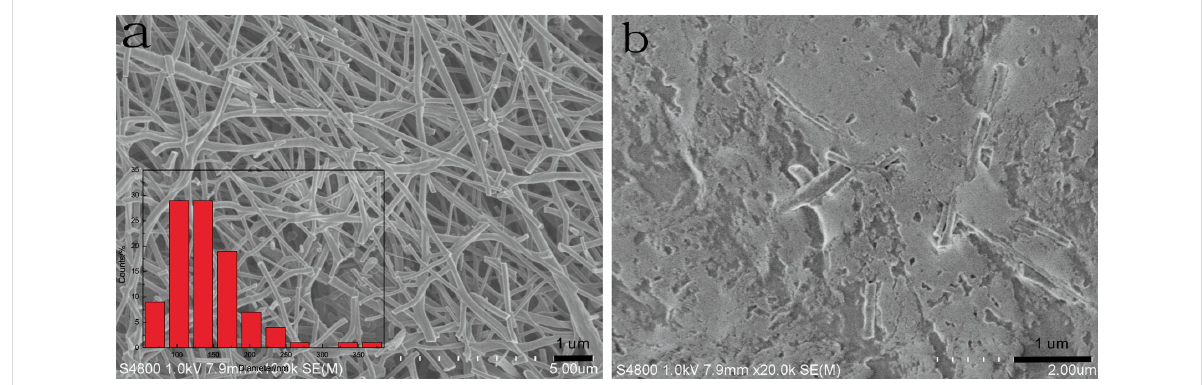
Figure 1: SEM images of the ECNFs (a) and the suface of laccase – Nafion–ECNFs/GCE (b). Insert: the diameter distribution diagram of the ECNFs.